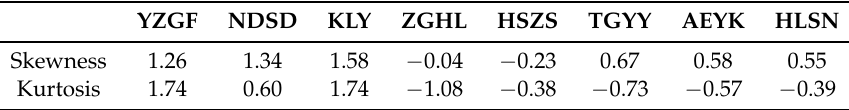
Table 3. Skewness and kurtosis of different financial